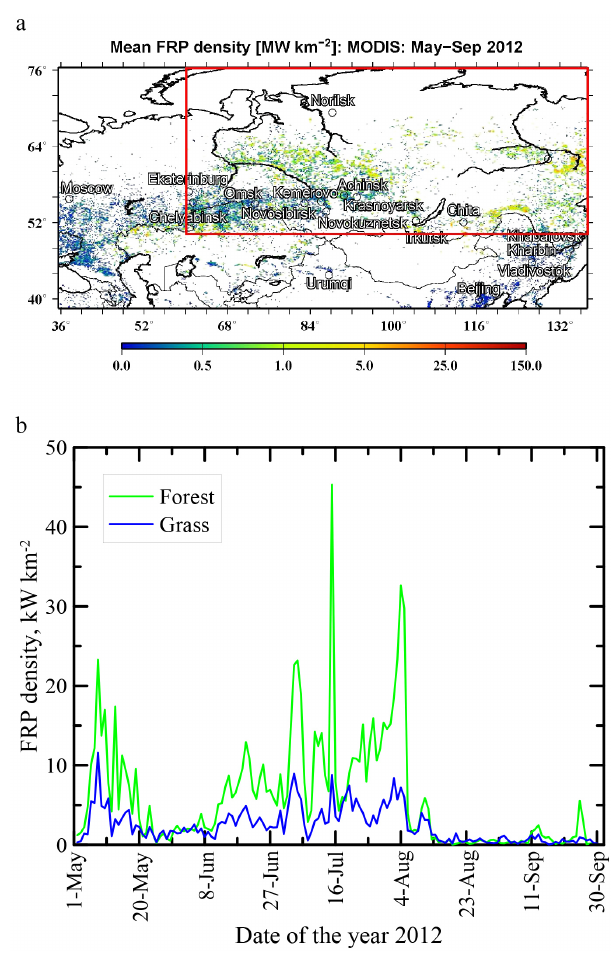
Figure 2. Average values of the daily maxima of the FRP density derived from the MODIS measurements: (a) spatial structure over the period chosen for data assimilation (from May to September 2012), (b) daily variations averaged over the region considered in this study (indicated by a red rectangle in a